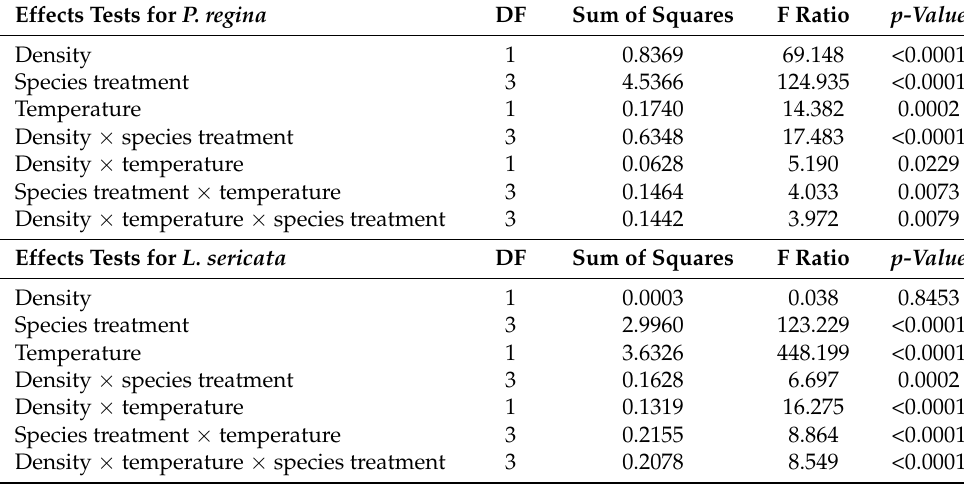
Table 1. General linear model testing the effects of temperature, density and species treatment on the female body size of Phormia regina Meigen and Lucilia sericata Meigen (Diptera: Calliphoridae). α = 0.05 for all